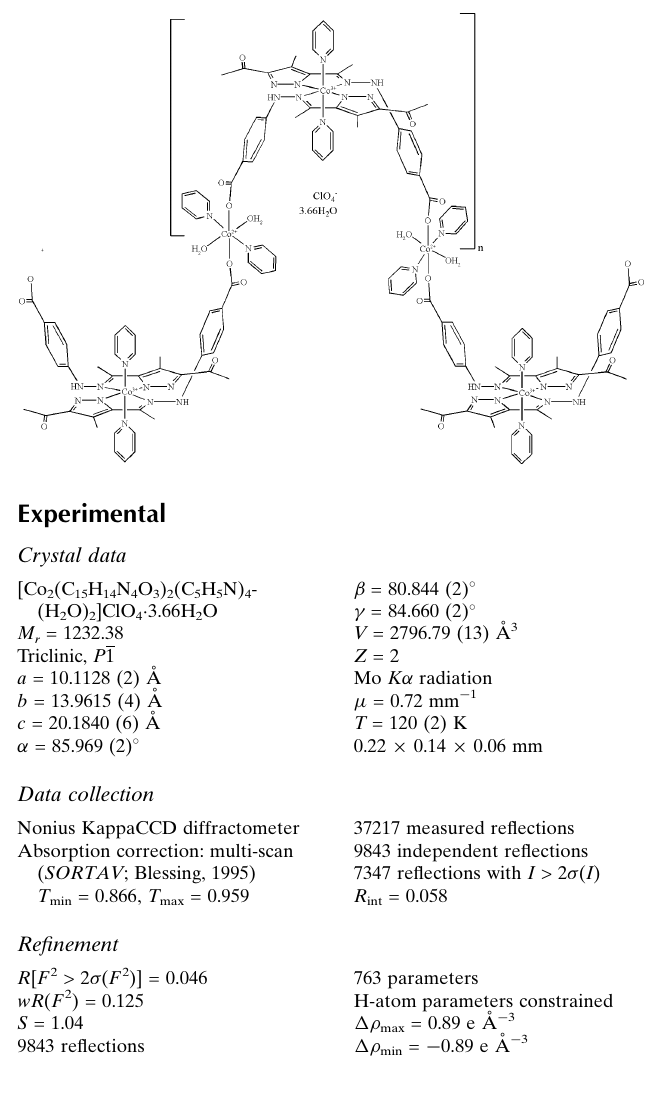
Hydrogen-bond geometry (A ˚ , (cid:3) ). D —H (cid:1)(cid:1)(cid:1)